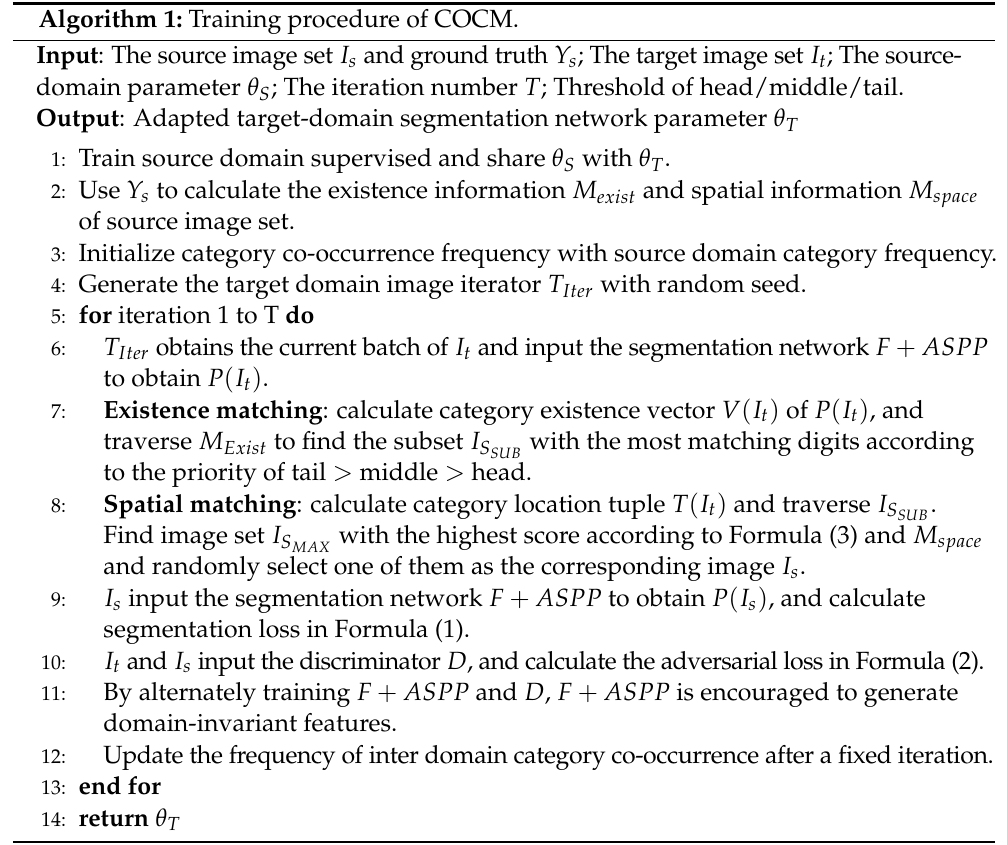
Algorithm 1: Training procedure of